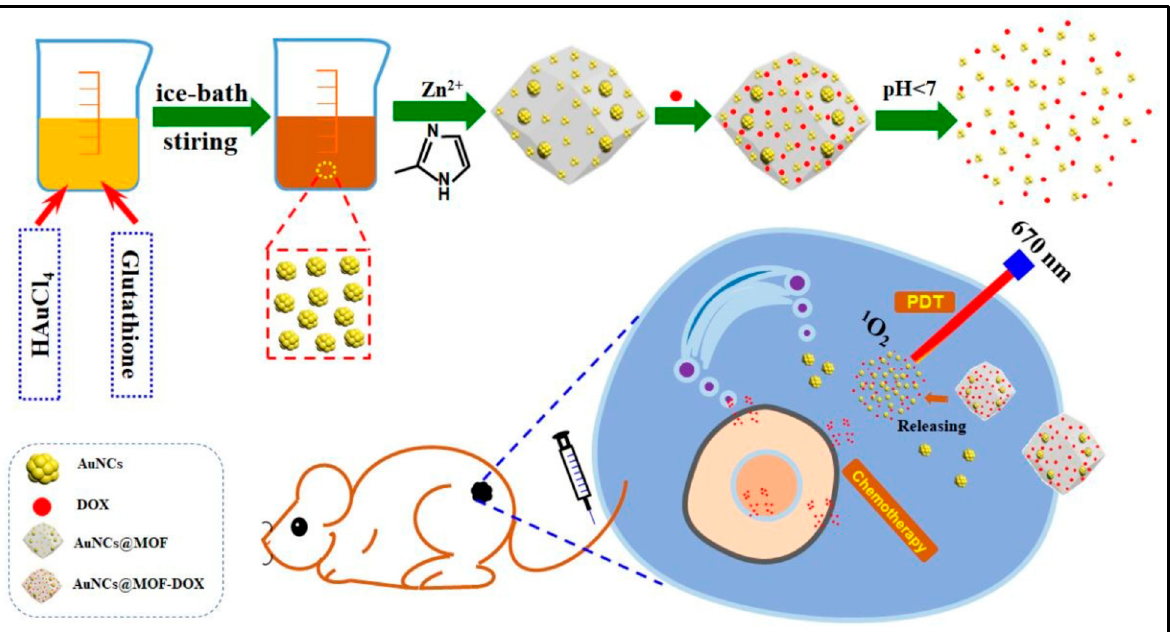
Figure 10. The synthesis process of AuNCs@MOF-DOX nanoprobes and their application in pH- responsive PDT and the chemotherapy of breast cancer. Doxorubicin: DOX. Reproduced with permission from [128], The Royal Society of Chemistry, 2020.